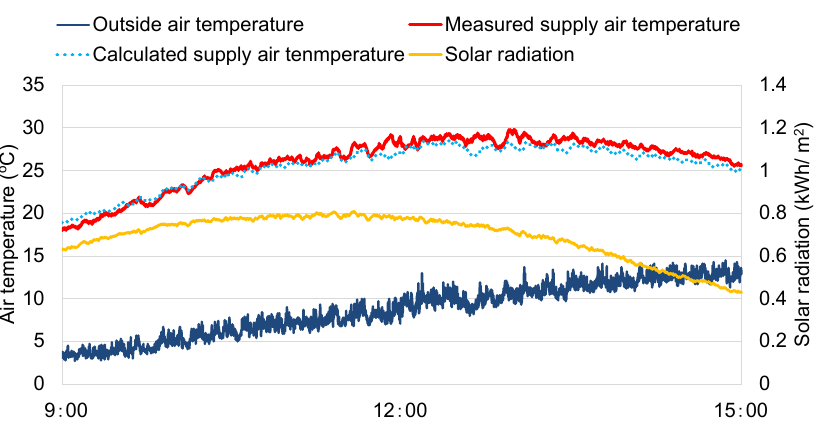
Figure 3. Measured and calculated supply air temperature.